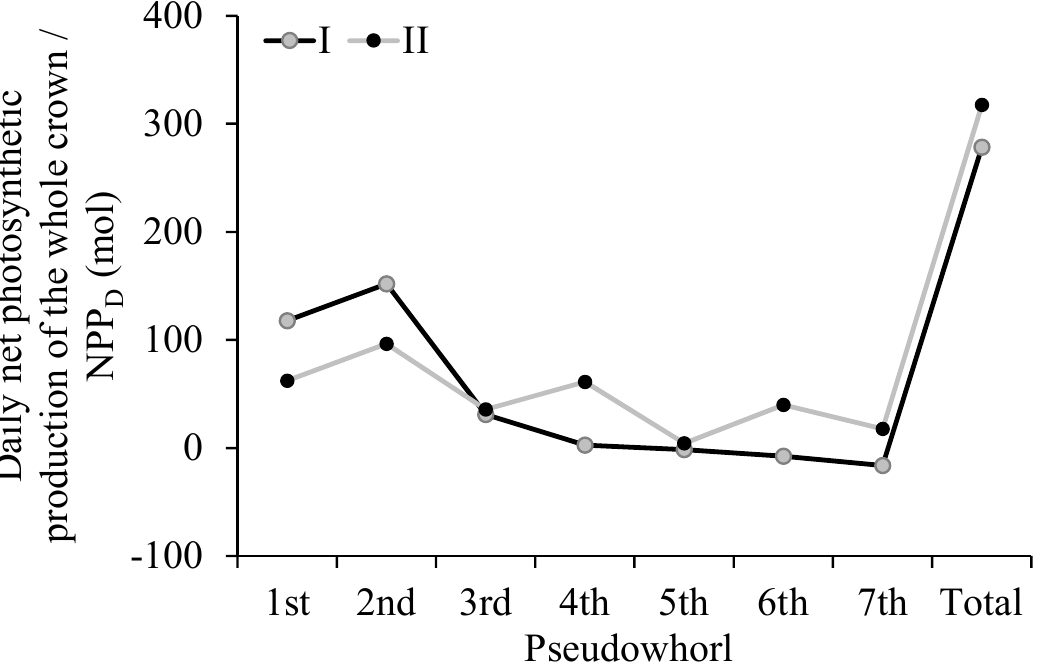
Figure 8. The daily net photosynthetic production of the whole crown (NPP D ) of each pseudowhorl and the whole crown for tree I. The k values for calculating NPP D were respectively determined based on the k model which was constructed in this study (I) and an optimum constant value of 0.33 (II).